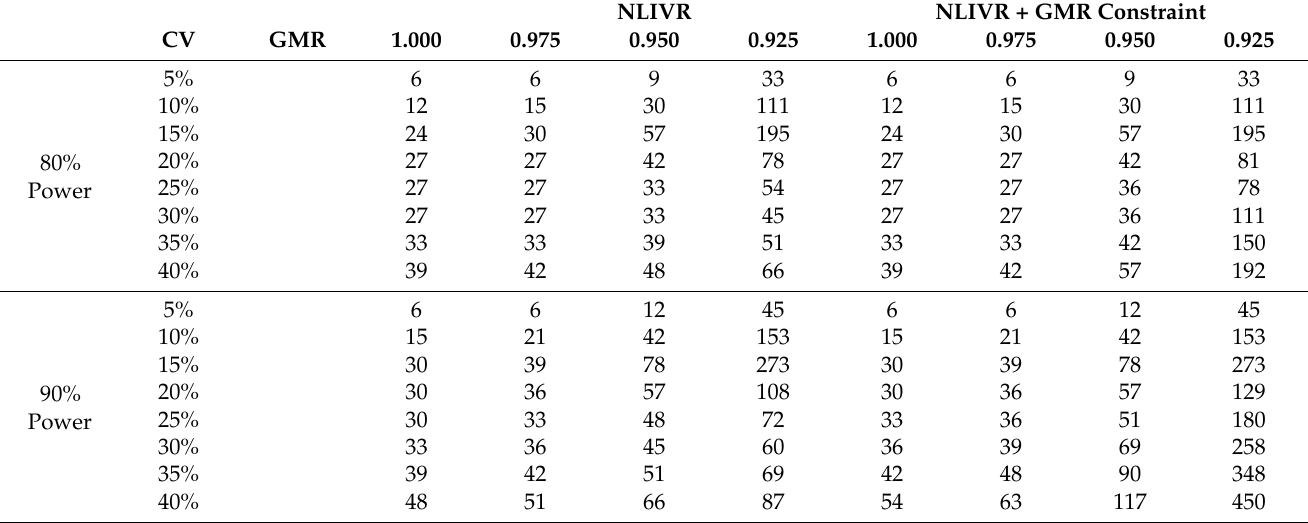
Figure 4. Sample sizes for the EMA current NTI criteria (EMA NTI), the proposed NLIVR conditions with (NLIVR + GMR constraint) and without (NLIVR) the GMR constraint for a power of 80%, assuming a GMR of ( A ) 1.000, ( B ) 0.975, ( C ) 0.950 and ( D ) 0.925. Table 1. Sample sizes with the proposed NLIVR conditions with and without considering the GMR constraint, with different theoretical GMRs, reference with-subject variabilities and for a power of 80% and 90%.